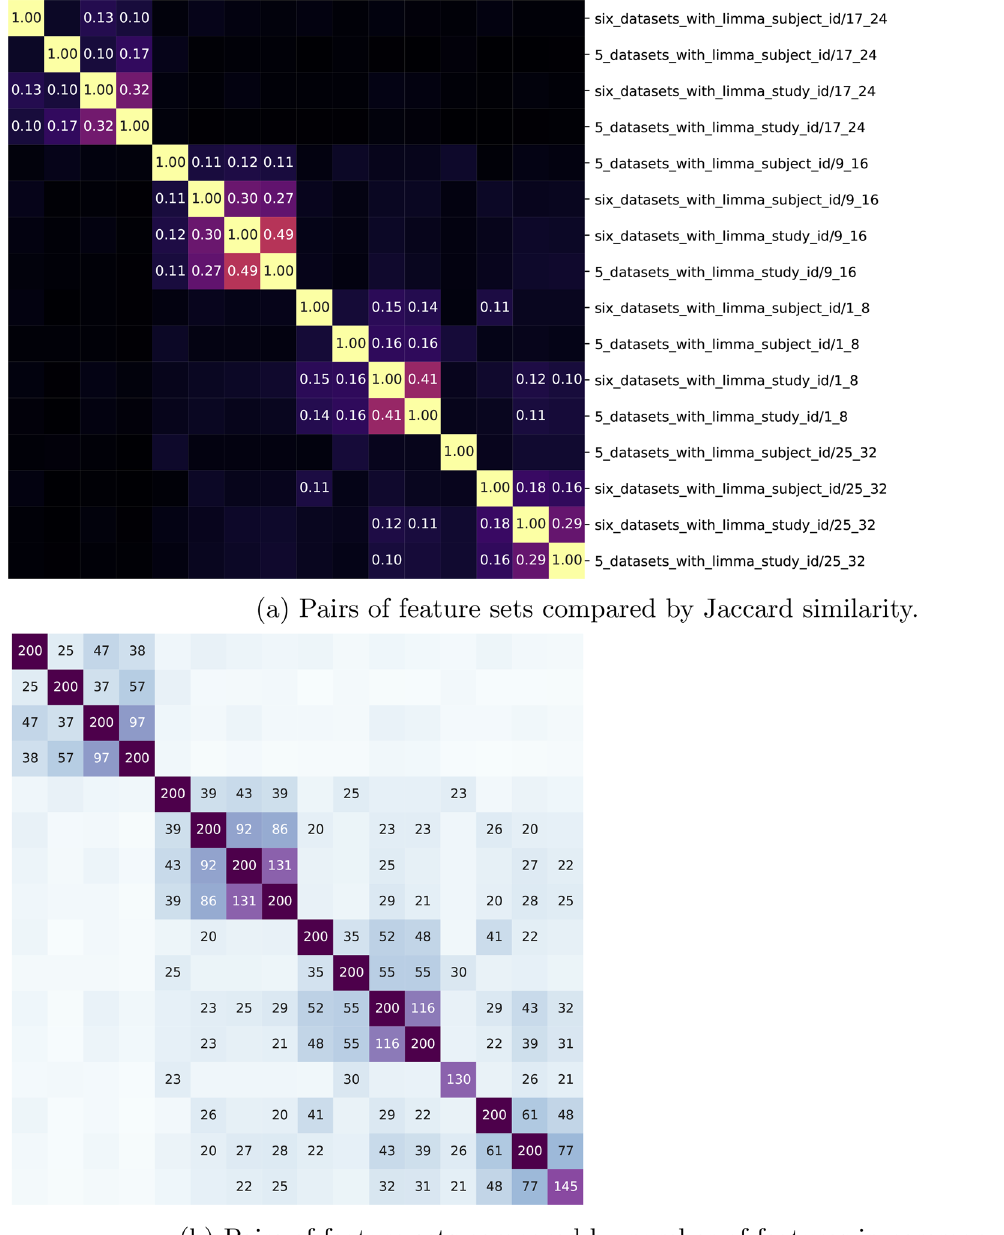
Figure 5. Comparison and clustering of the sixteen distinct feature sets generated based on different subsets of the data. The similarity matrix used for clustering is based on the Jaccard metric between sets measuring the size of the intersection of two sets divided by the size of the union—which ranges from 0 (no features in common) to 1 (perfect match). ( a ) Similarity matrix using the Jaccard metric shown. Two strong clusters and a weaker third cluster is seen primarily based on data inclusion, with variation within-cluster based on preprocessing. Rows follow the format “study_preprocessingtime_range”. For instance, “17_24” refers to hours 17–24 after inoculation. ( b ) The same matrix is shown (same cluster order), but with absolute number of features in common illustrated instead (note most feature sets have 200